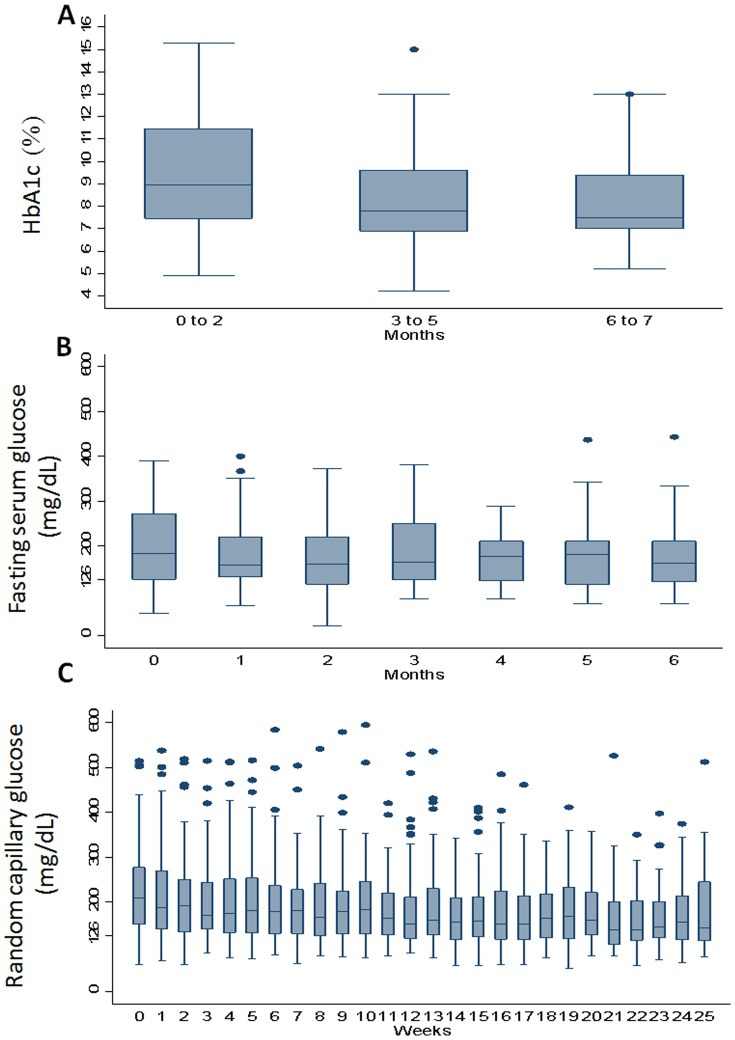
Medians +95% Confidence intervals of measures of glycaemia at each visit among patients with TB and DM during TB treatment (Tijuana, Ciudad Juarez, Reynosa, Guadalupe and Zapopan, Mexico, 2012–2013.Panel A, HbA1c (%); Panel B, Fasting serum glucose (mg/dL); Panel C, Capillary random blood glucose (mg/dL). As TB treatment progressed, the levels of HbA1c and random capillary glucose showed a significant decreasing trend, (regression coefficients (β) −0.660, (95% confidence interval (CI), −0.96 to −0.35); and β = −1.889 (95% CI −2.77 to −1.01, respectively) adjusting by sex, age and having had treatment for a previous TB episode.